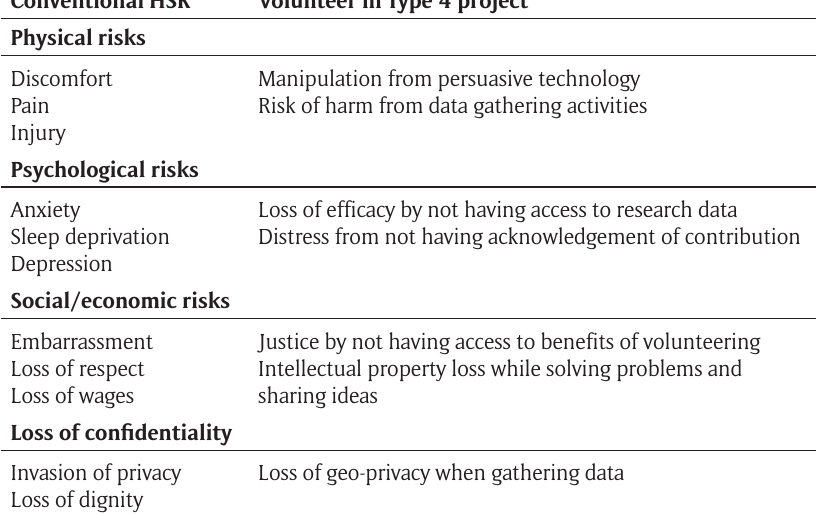
Table 1: The typical risks tend to be different for conventional human subjects than for volunteers in Type 4 citizen science